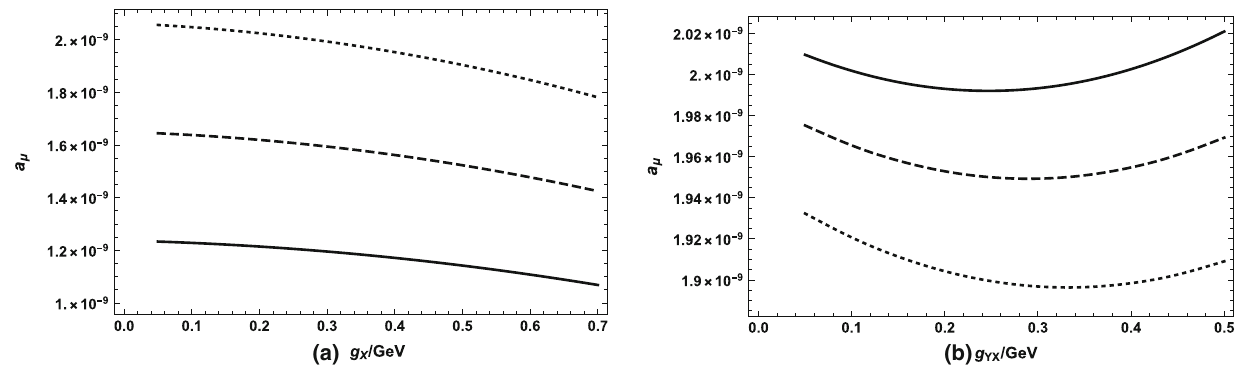
Fig. 6 a μ versus g X ( a ) and g YX ( b ). The dotted line, dashed line and solid line in a correspond to tan β equal to 50, 40 and 30 respectively. In b , the solid (dashed, dotted) line corresponds to the results with g X = 0 . 3 ( 0 . 4 , 0 . 5 )